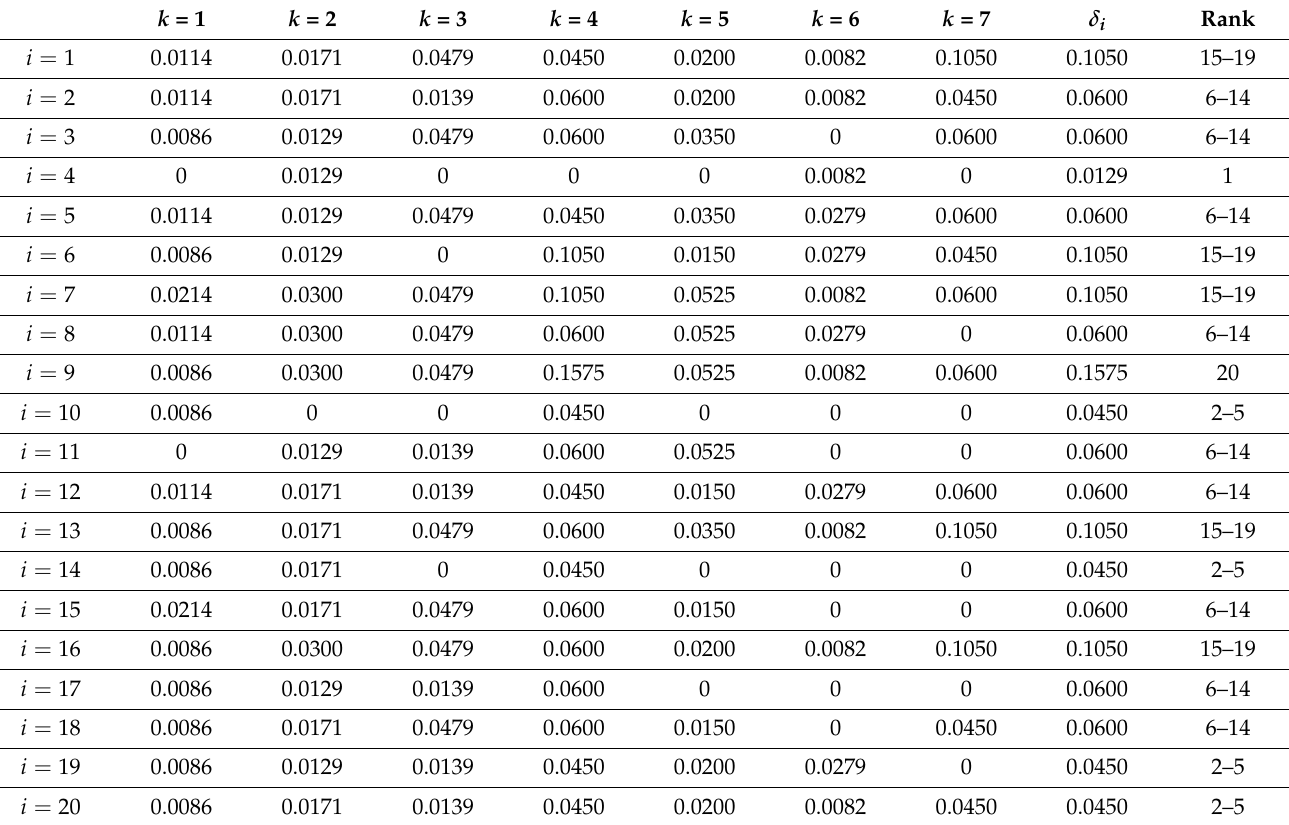
Table 6. The rank of enterprises based on the reference